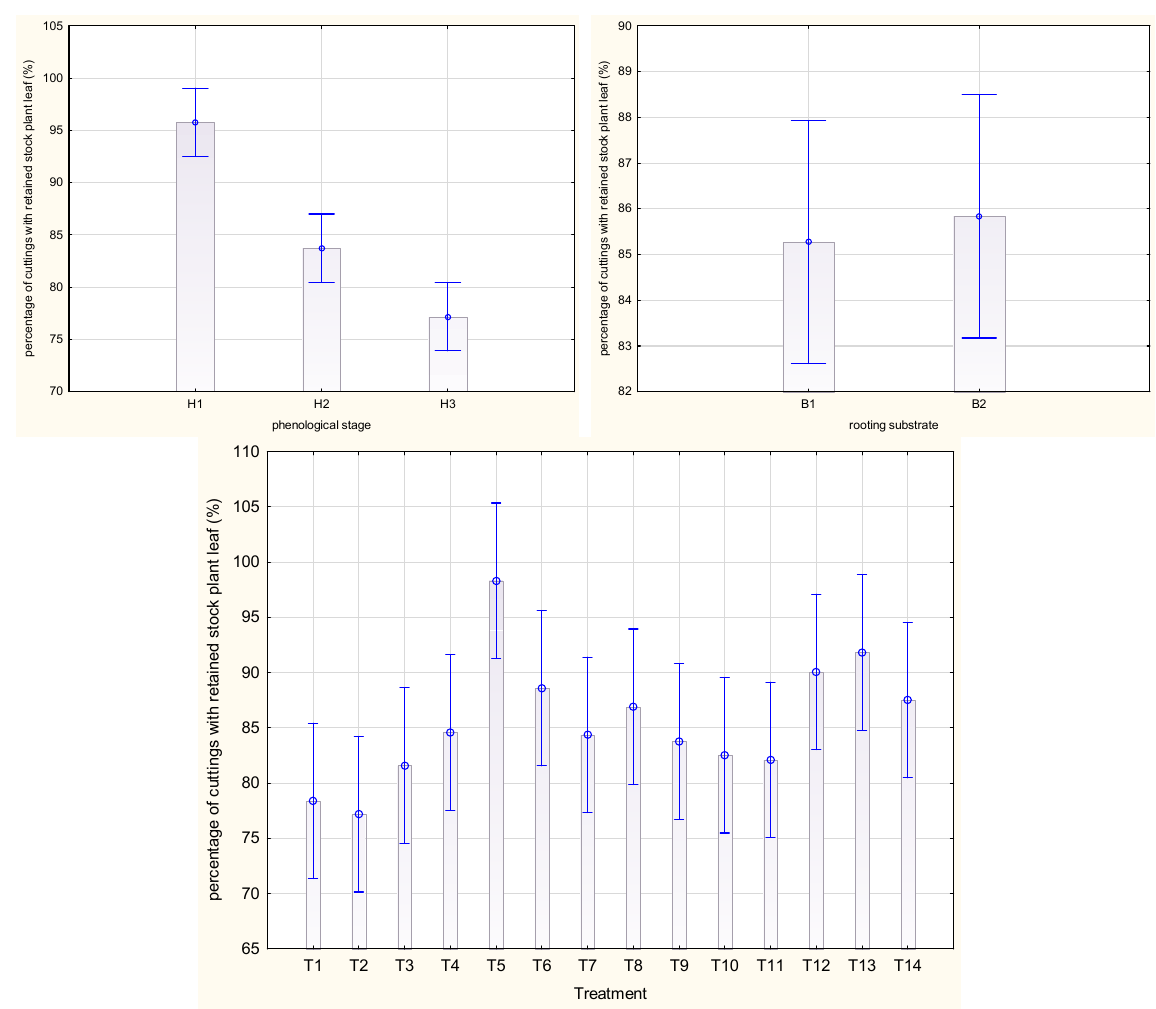
Figure 5. Percentage of cuttings with retained stock plant leaf in Rosa ‘Hurdal’ cuttings prepared from three phenological stages (H1–H3) of shoots and rooted in two rooting substrates after treatment by rooting enhancers. B1—peat–perlite; B2—peat–sand; H1—flower buds closed (BBCH 54,504;